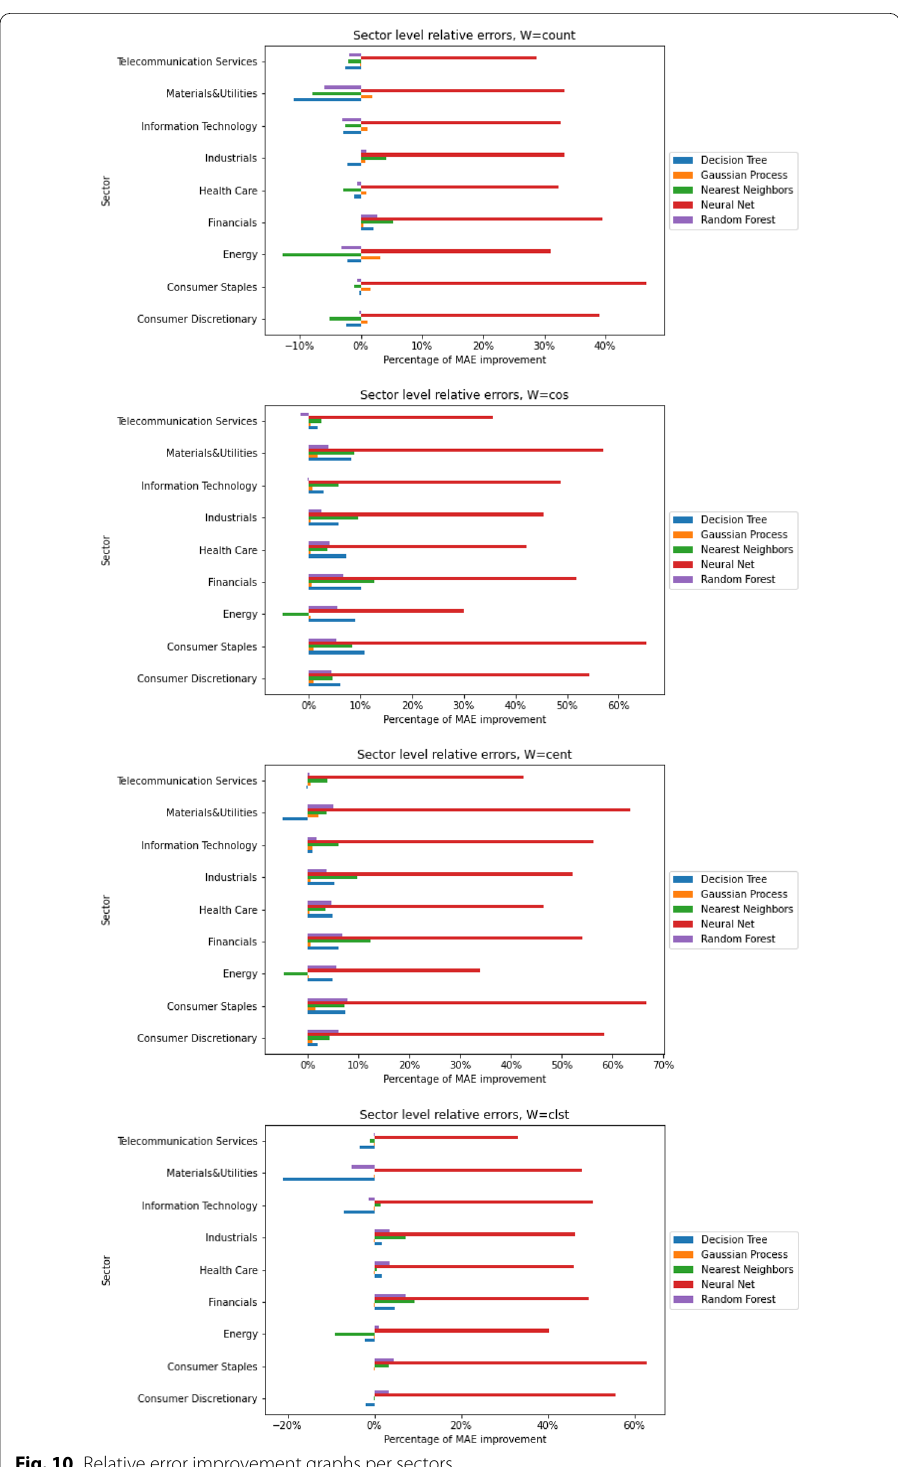
Fig. 10 Relative error improvement graphs per